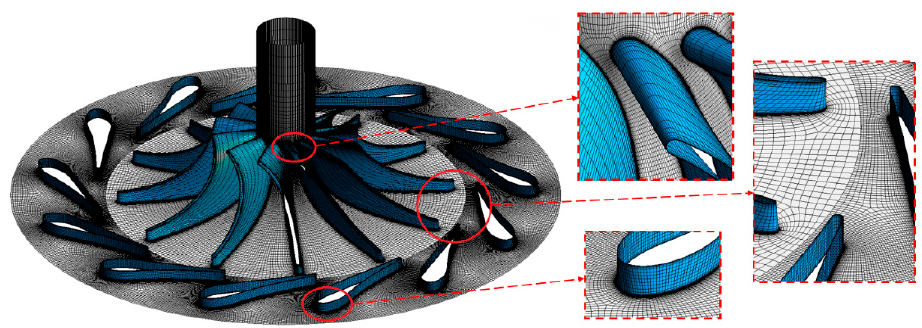
Figure 5. Mesh of the computational field.